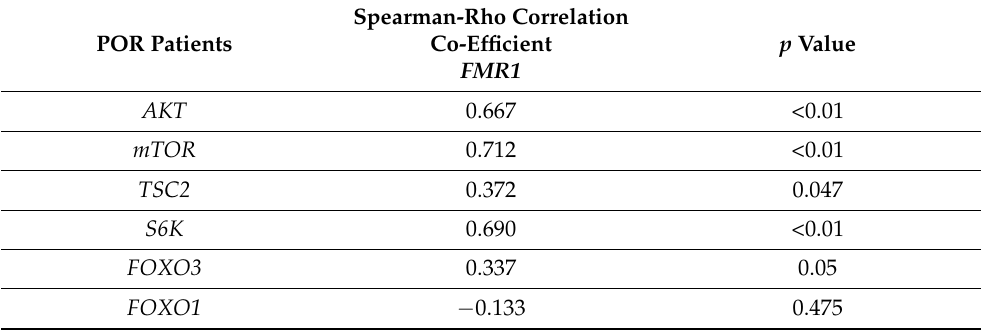
Table 4. Correlations of FMR1 gene expression with AKT1 , FOXO3 , FOXO1 , mTOR , TSC2 , and S6K expressions according to ovarian response group (POR). The relative gene expression in granulosa cells of patients was normalized by two housekeeping genes and a granulosa cell calibrator using the ∆∆ Ct method. Correlation was calculated using the Spearman–Rho correlation coefficient.